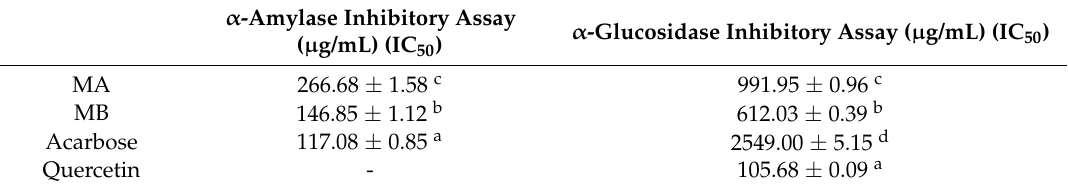
Table 1. α -Amylase and α -glucosidase inhibitory activities of Momilactones A (MA) and Momilactones B